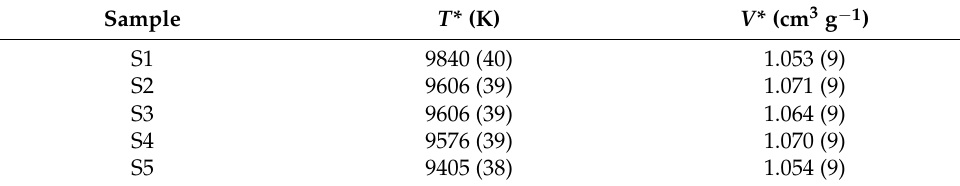
Table 1. Scaled thermodynamic parameters V * and T * for the investigated elastomers. Uncertainties are shown in parenthesis.